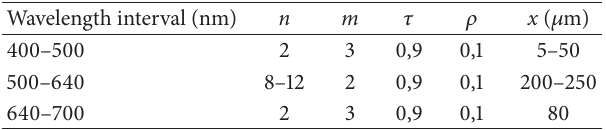
Table 1: Parameters used for modelling of internal reflectance theoretical spectrum of Spring barley (control group).